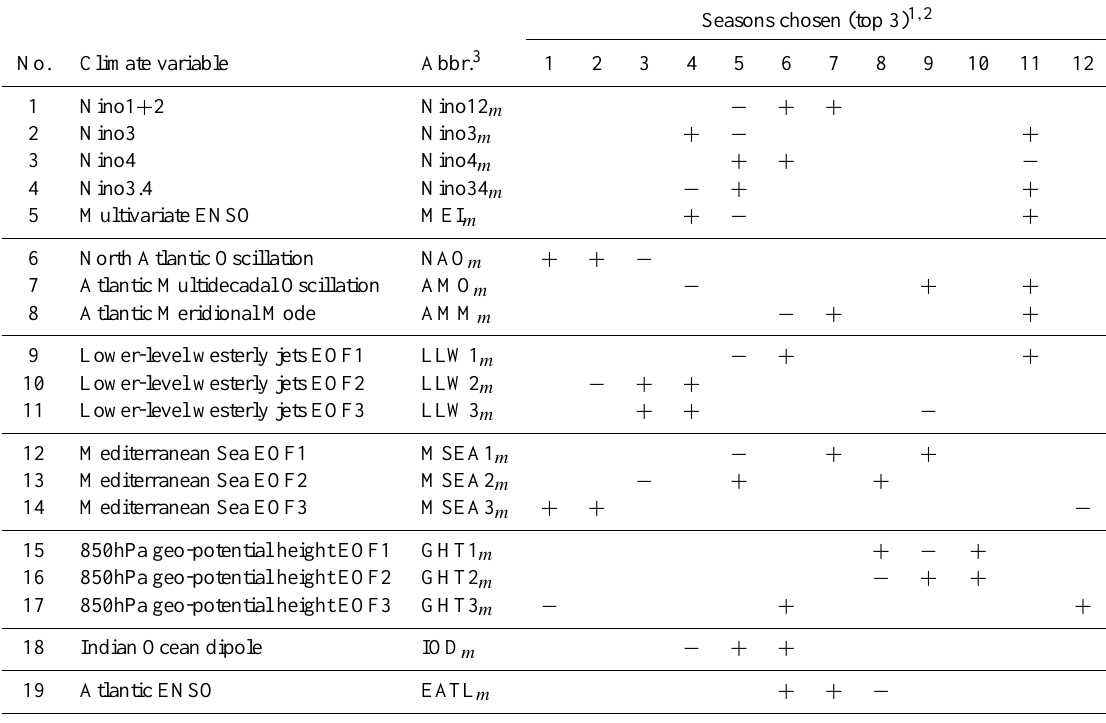
Table 1. Prominent season selections for climate